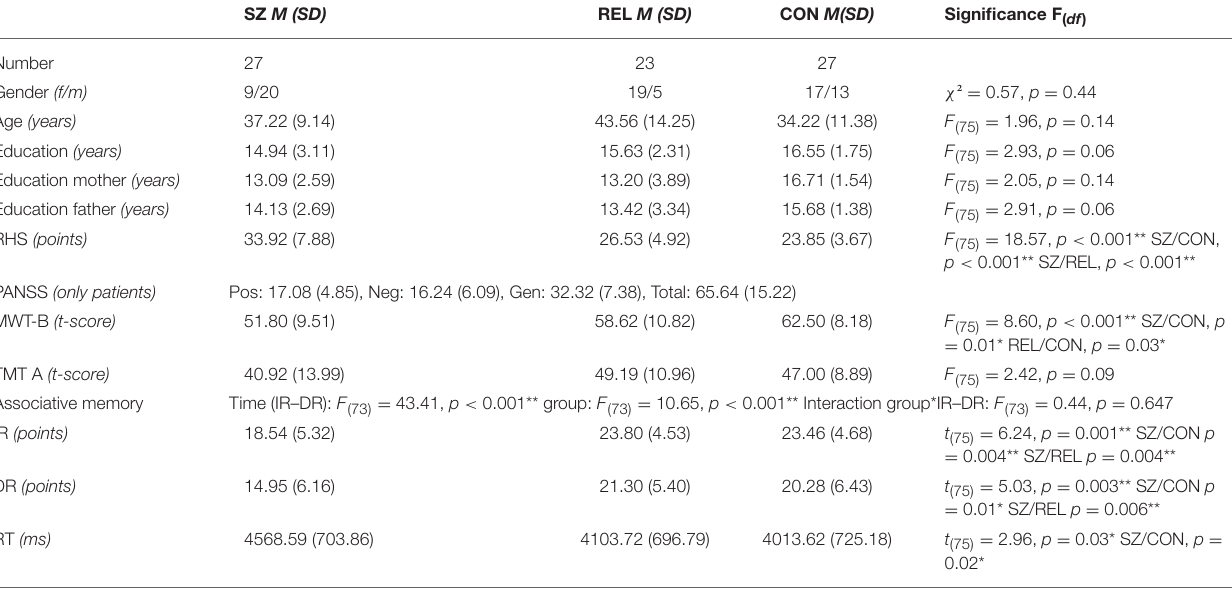
TABLE 1 | Group comparisons of sociodemographic and cognitive data across groups (corrected for multiple comparisons using the Bonferroni